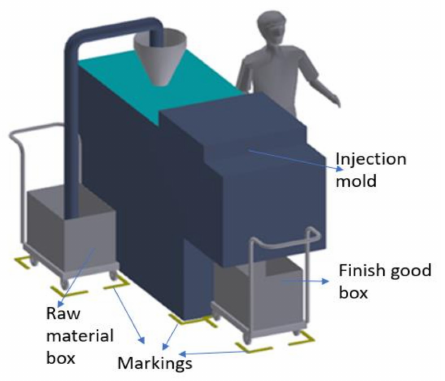
Figure 24. Standardized workstation.